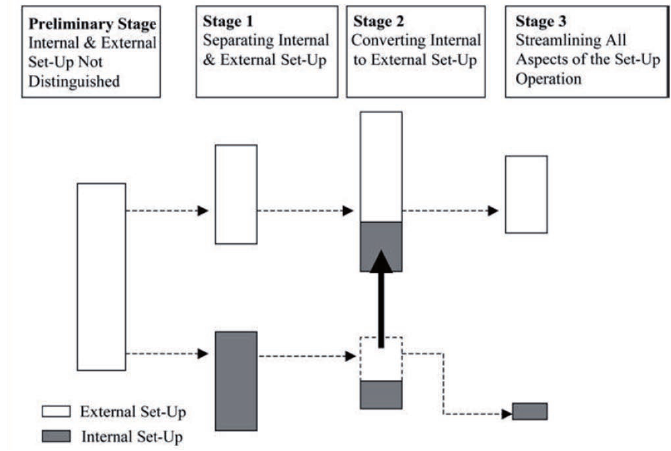
Fig. 1 – Original SMED conceptual stages (Moxham & Greatbanks,